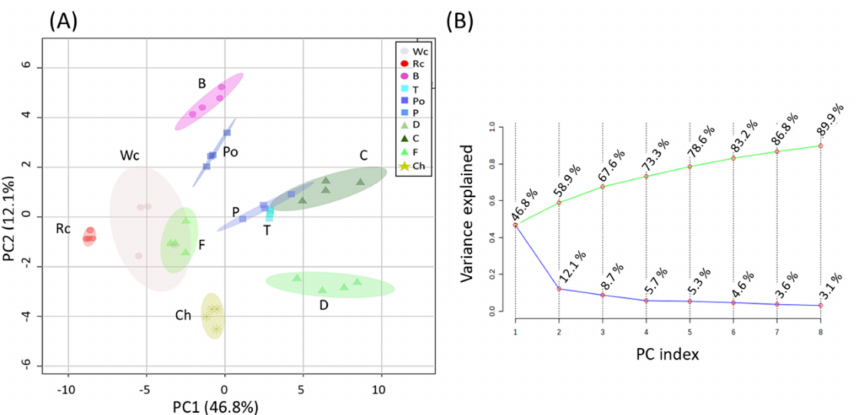
Figure 1. ( A ) Principal component analyses (PCA) applied to the levels of individual primary metabolites of P. aegyptiaca grown on 10 host plants according to the 58 primary metabolites. The data points are displayed as projections onto the two primary axes (eigenvectors). Variances explained by the first two components (PC1 and PC2) appear in parentheses. Host plants are designated as Broccoli (B), Red cabbage (Rc), White cabbage (Wc), Potato (Po), Pepper (P), Tomato (T), Carrot (C), Dill plant (D), Fennel bulbs (F) and Chickpea (Ch); ( B ) Display of the Scree plot of eight PCs. The green line on top shows the accumulated variance; the blue line below shows the variance explained by the individual PC.